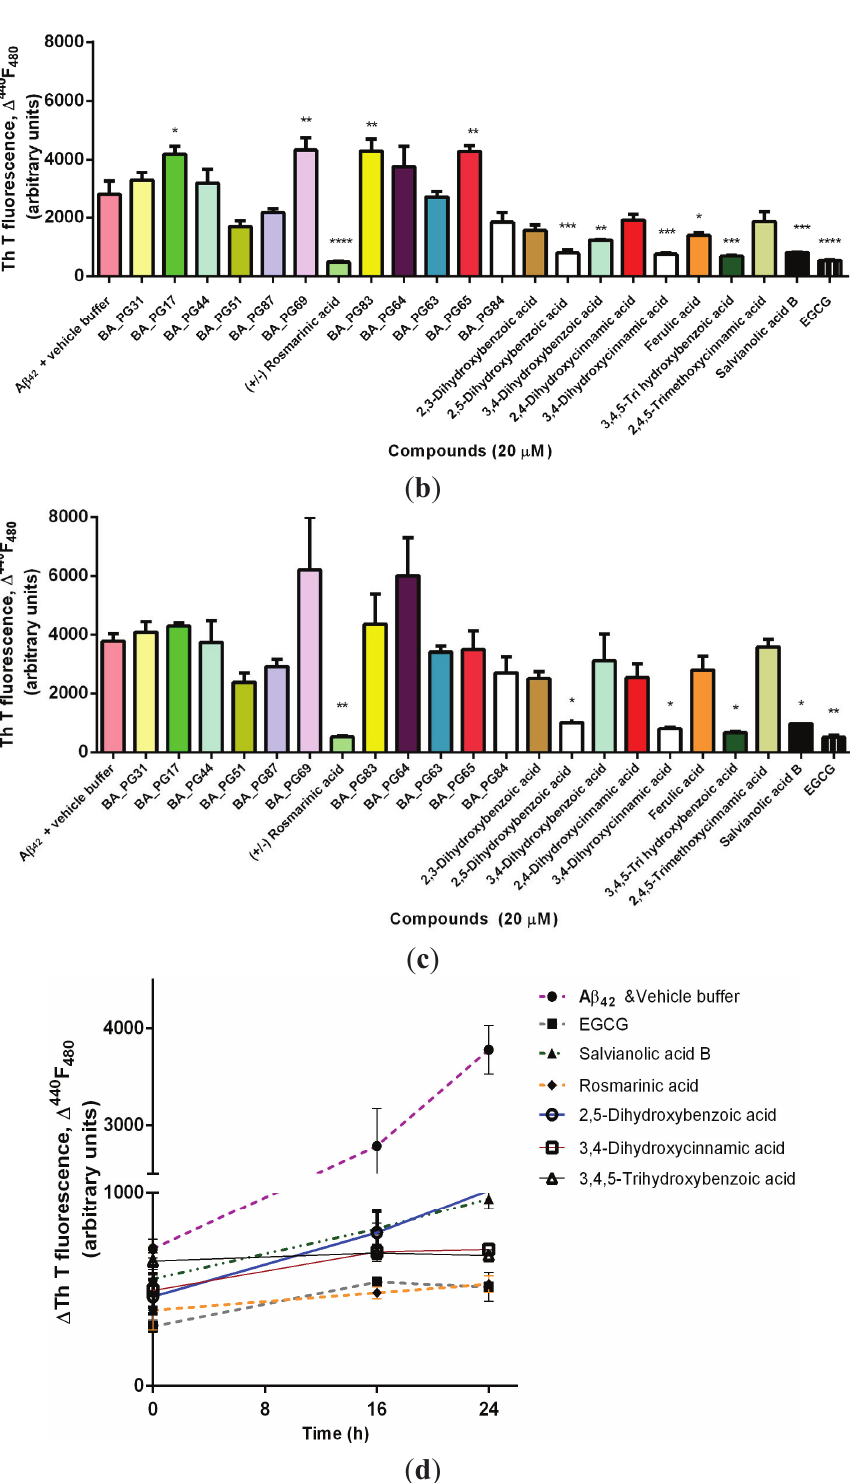
Figure 1. Amyloid formation assayed by thioflavin T fluorescence. ( a ) Fibril formation of A(cid:2) 42 and the associated increase in in situ ThT fluorescence in presence and absence of compounds were measured at 0 h (baseline) ( b ) after 16 h ( c ) and after 24 h incubation; ( d ) Selected phenolic compounds that resulted in a significant anti-amyloidogenic property compared with the positive control (EGCG) and negative control (A(cid:2) 42 & vehicle buffer) determined by ThT measured at 0, 16, and 24 h after incubation with chemically synthesized A(cid:2) 42 . Significant differences are indicated: * p < 0.05; ** p < 0.01; *** p < 0.005; **** p <